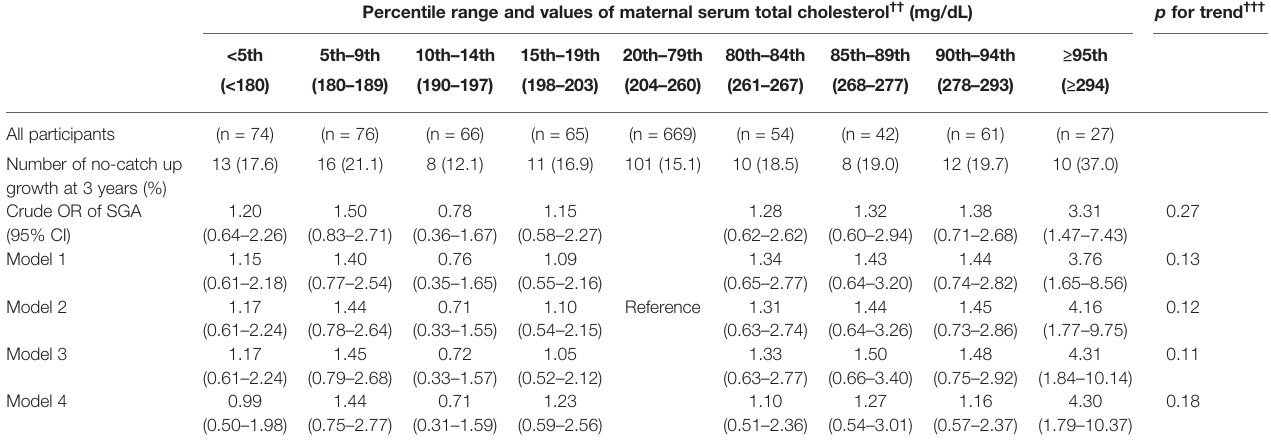
TABLE 4 | Odds ratios of no-catch up growth at 3 years among infants born small-for-gestational-age †† total cholesterol value at mid-pregnancy in the complete dataset (n = 1,134). Percentile range and values of maternal serum total cholesterol ††